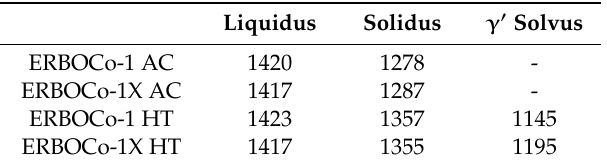
Table 2. Characteristic transformation temperatures in ◦ C as determined from the heating segments from DSC measurements in the heat-treated